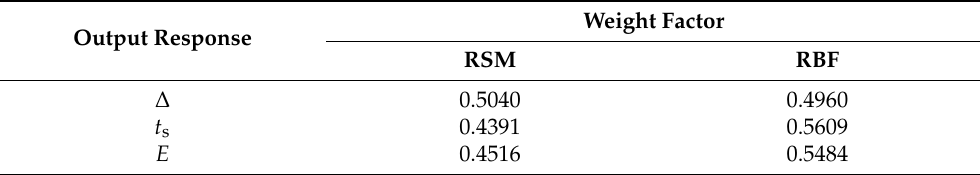
Figure 17. R 2 value of RSM, RBF, and Kriging surrogate models. Table 2. Single surrogate model weight coefficients. Table 2. Single surrogate model weight coefficients.